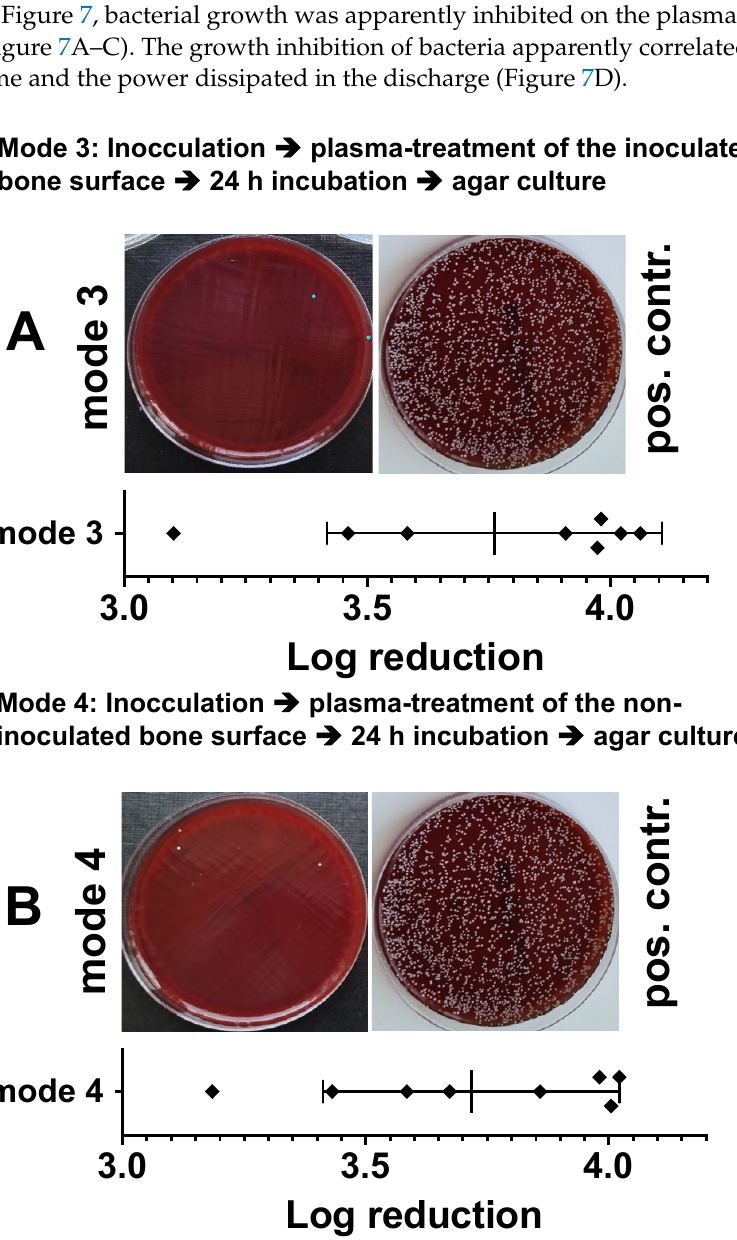
Figure 6. Characterization of the antibacterial effect of DBD CAPs in a model of a bacterially contaminated bone preparation. Punch preparations from the pork shoulder blade were inoculated with the Staphylococcus epidermidis strain (1.5 × 10 6 ). Immediately (approximately 10–15 min) after bacterial inoculation, the non-contaminated area ( A , mode 3) or the bacterially contaminated side ( B , mode 4) of the specimens were exposed to the DBD plasma (10 min at 275 mW power dissipation in the discharge). After 24 h, the bacteria were detached from the bone preparations and the resulting bacterial solutions of mode 3 or mode 4 were spread out on agar plates (photographic images of mode 3 or mode 4). As a positive control (pos. contr.), the corresponding bone samples were treated identically, but not exposed to plasma. The quantitative evaluation was carried out by counting the photographically recorded colonies on the agar plate using the imageJ software. Bars shown represent the mean ± S.D. of six individual experiments. *, p < 0.05 as compared to the positive control (pos.